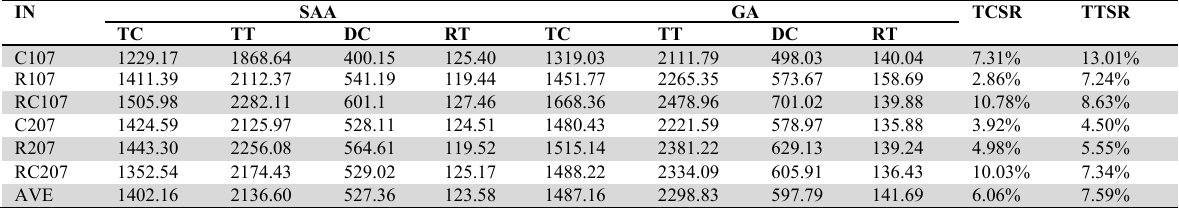
Experimental results on different optimization algorithms